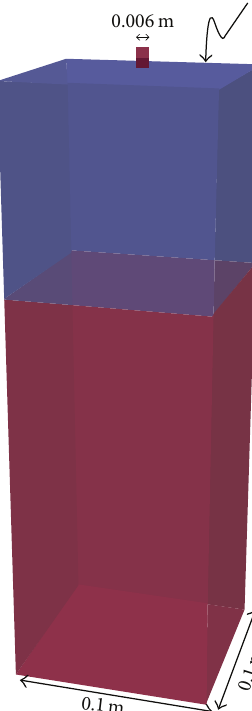
Figure1:Computationaldomainshowingtheinitialwater(red)and air (blue)